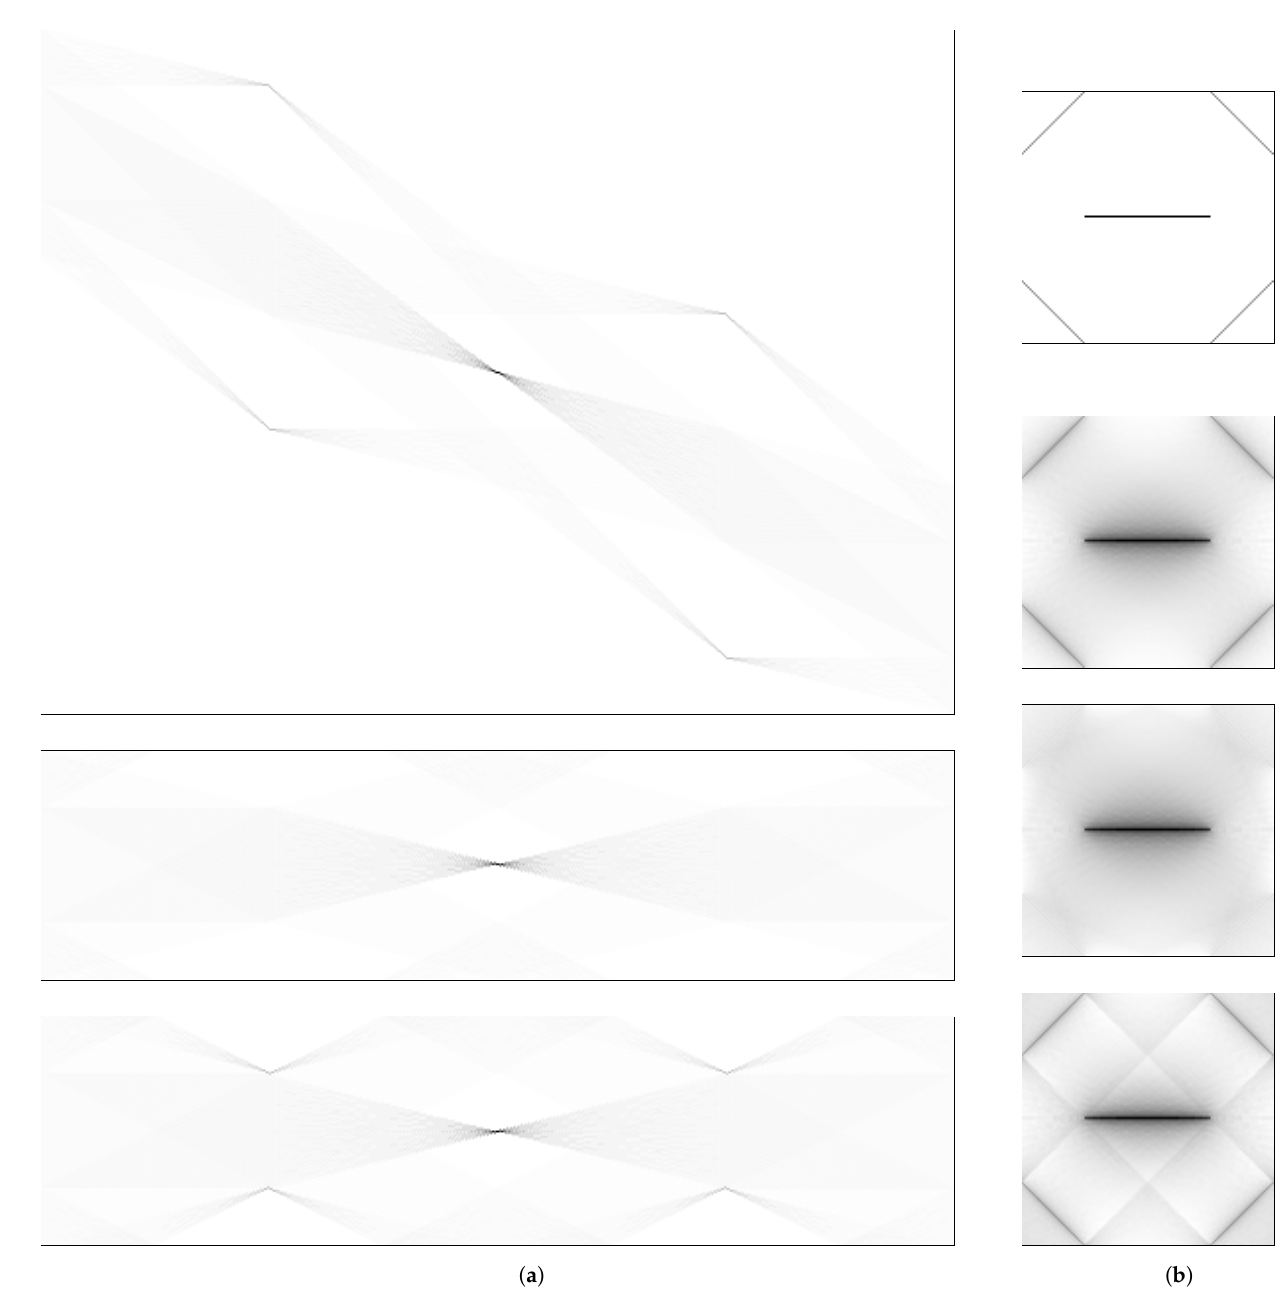
Figure 18. Forward and back-projected transforms of an input, consisting of one horizontal line in the center and four lines closer to the corners. From top to bottom: conventional, central, and periodic DRT. ( a ) Forward transforms; ( b ) Input and